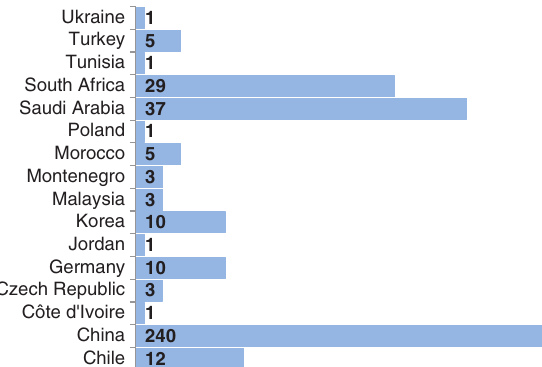
Fig. 1: Distribution by